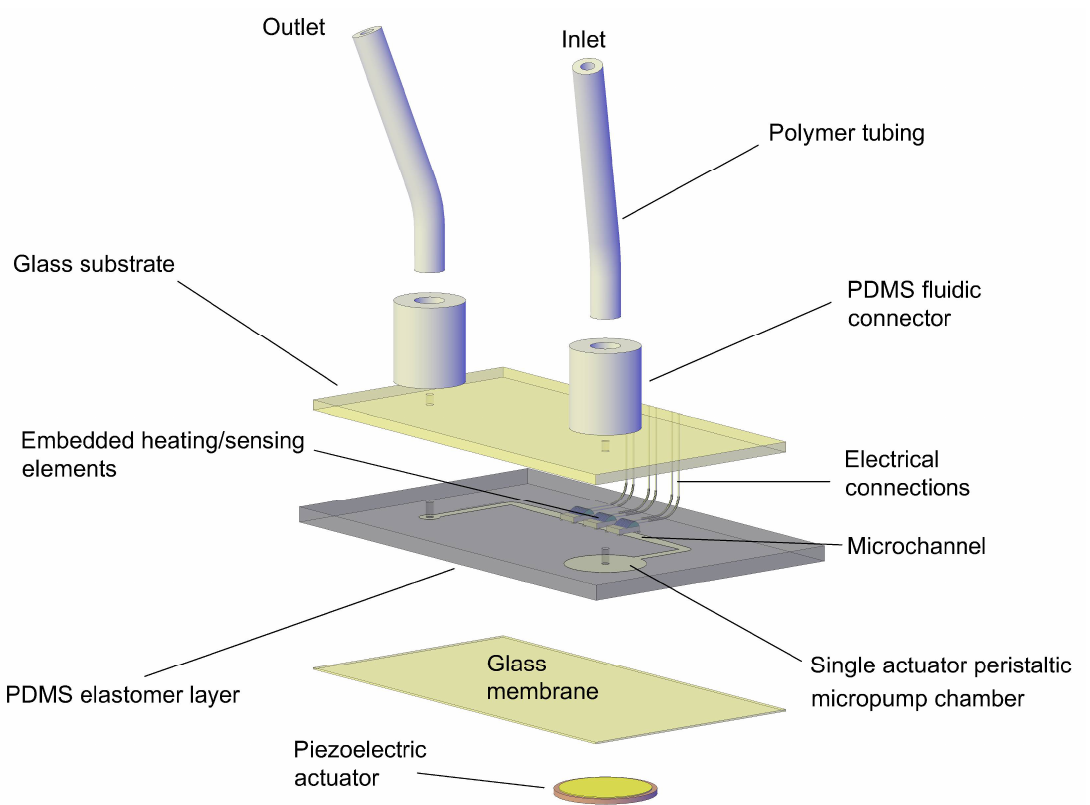
Figure 1. An exploded view drawing of the microfluidic chip comprising the piezoelectric micropump and the micro flowmeter in the